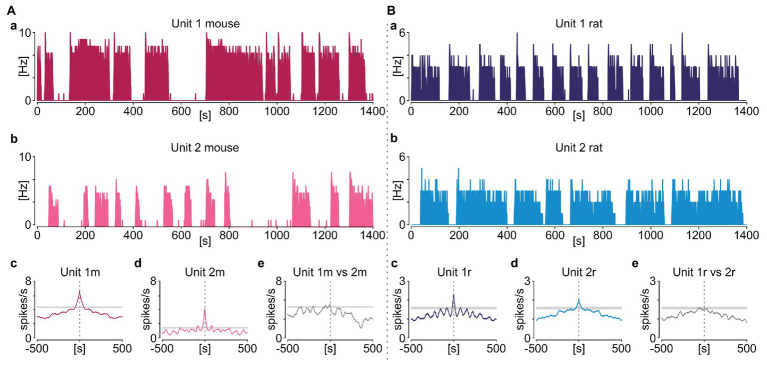
Phasic activity in the NTS is not synchronised amongst its neurons. Example pairs of simultaneously recorded NTS neurons displaying phasic activity pattern in mouse (A) and rat (B). (a,b) Firing rate histograms for individual neurons (bin: 1 s). (c,d) Corresponding autocorrelograms (bin: 1 s). (e) Cross correlation between two units. 95% CIs are coded by grey boxes.